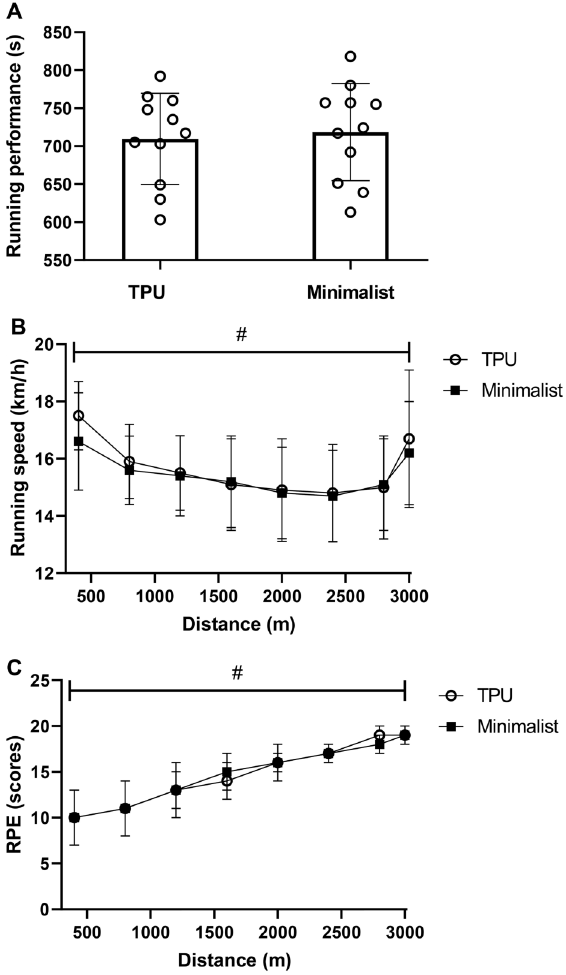
Figure 2. A , Overall performance; B , running speed distribution; C , rating of perceived exertion (RPE). TPU: midsole material composed by thermoplastic polyurethane. Data are reported as means ± SD. # P o 0.05 for main effects for distance ( t -test and